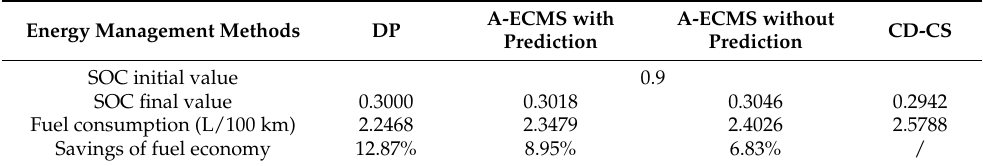
Table 5. Comparison of simulation results of different energy management methods.